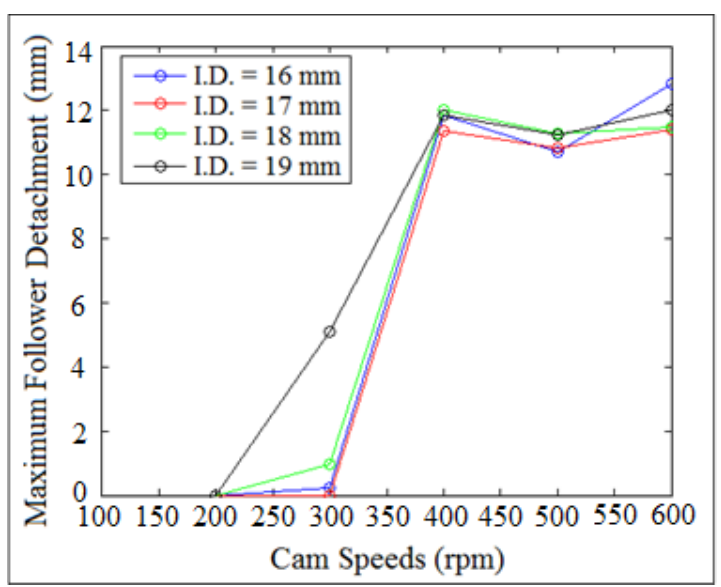
Figure 33. Maximum follower detachment heights against cam speeds.